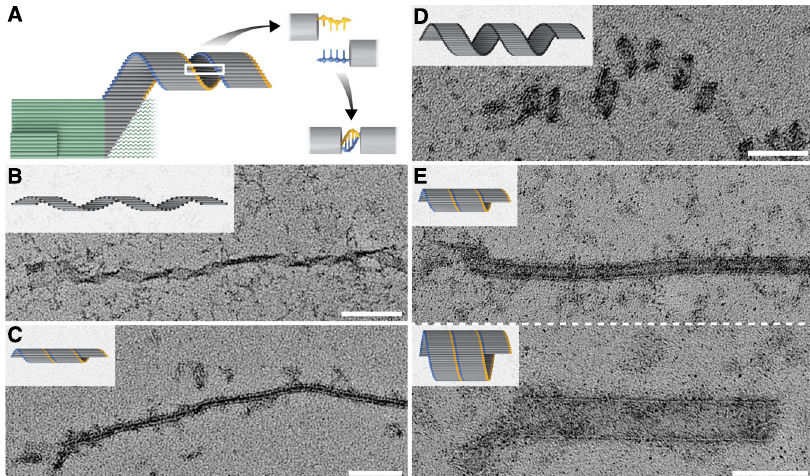
Fig. 4 Formation of tubes and coiled ribbons. A Seeded growth of a coiled ribbon. Coiled ribbons can be closed with sticky-end overhangs, as indicated with gold and blue. B v8.3 slats without sticky ends form open, tightly coiled ribbons. C v8.3 slats with 3 nt sticky ends form closed tubes of constant diameter. D v8.1 slats without sticky ends form open and loosely coiled ribbons (note the difference from the coiled ribbon in B ). E v8.1 slats, with 4 nt sticky ends, form closed tubes of varying diameters in a single reaction. Scale bars are 100